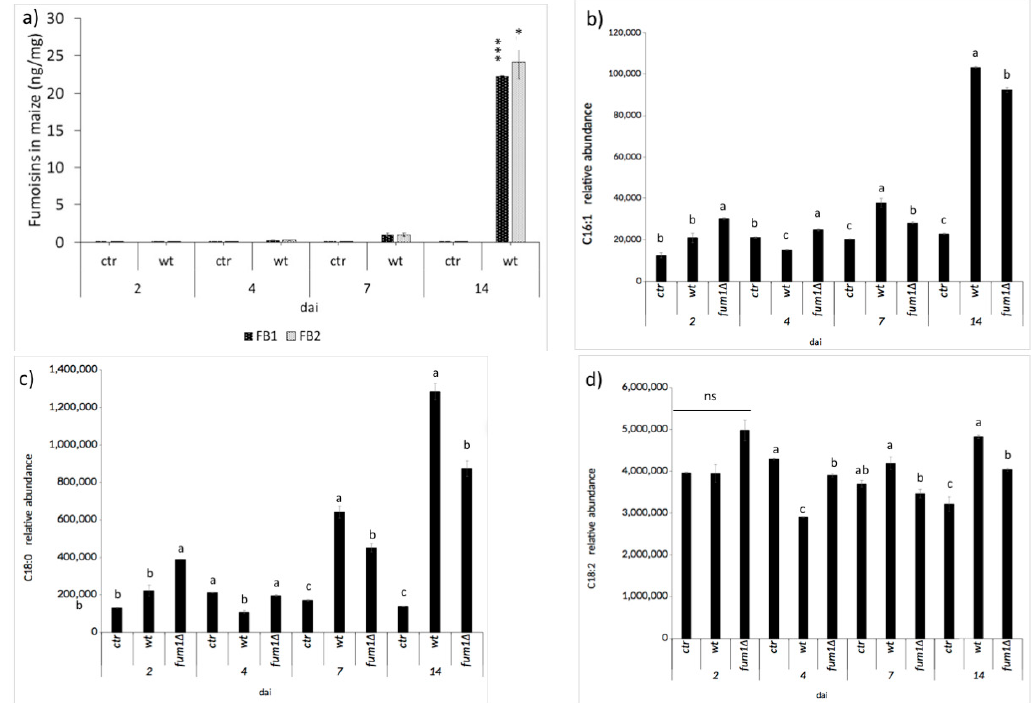
Figure 3. Toxin and fatty acid content were evaluated in seedlings non-infected (ctr) and infected by wild-type (wt), or by fum1 deletion mutant ( fum1 ∆ ). ( a ) Fumonisins (FB1 and FB2) in wt-infected and in the ctr seedlings at several days after infection (dai) analyzed by an MRM (Multiple Reaction Monitoring) approach with HPLC–MS/MS. The error bars represent standard error calculated from three independent replicates, technically repeated in triplicate. Asterisks indicate a significant difference at same time point from ctr (Student’s t -test: * p < 0.05; *** p < 0.001). ( b ) C16:1 ( c ) C18:0 ( d ) C18:2 fatty acids in infected (wt or fum1 ∆ ) and ctr seedlings at several dai analyzed by a single ion monitoring (SIM) with HPLC–MS/MS. The error bars represent standard error calculated from three independent replicates, technically repeated in